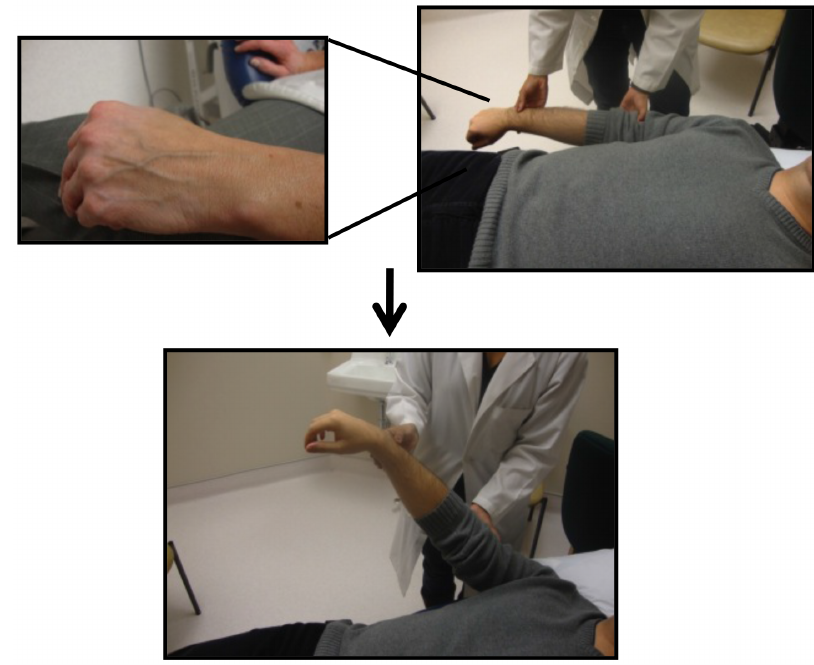
Figure 2. Assessment of Peripheral Venous Collapse; the classical peripheral venous collapse technique.